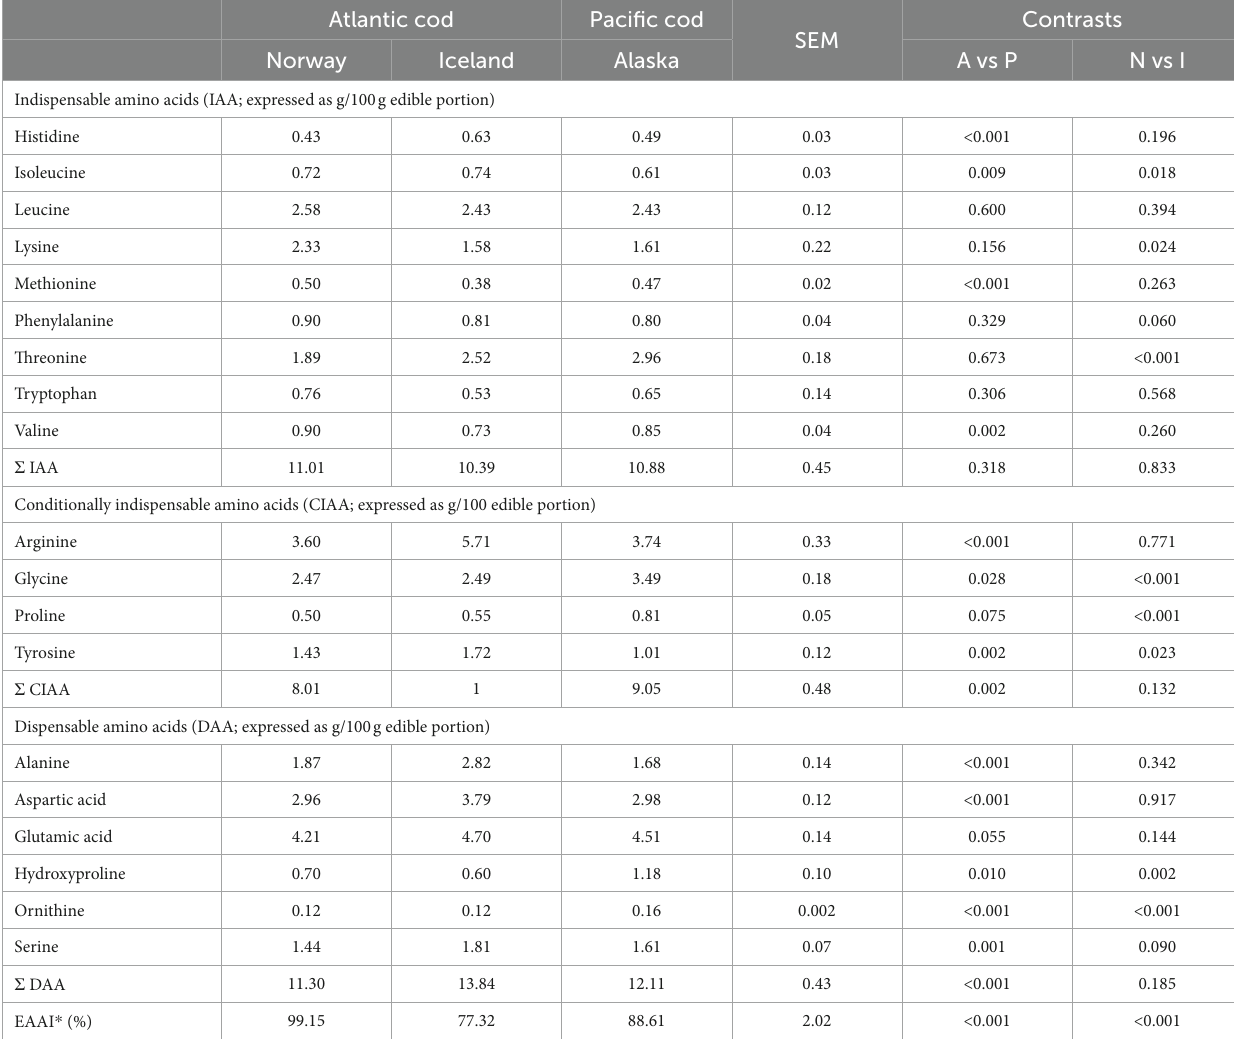
Contrast A vs P: Atlantic cod versus Pacific cod; Contrast N vs I: Norwegian cod versus Icelandic